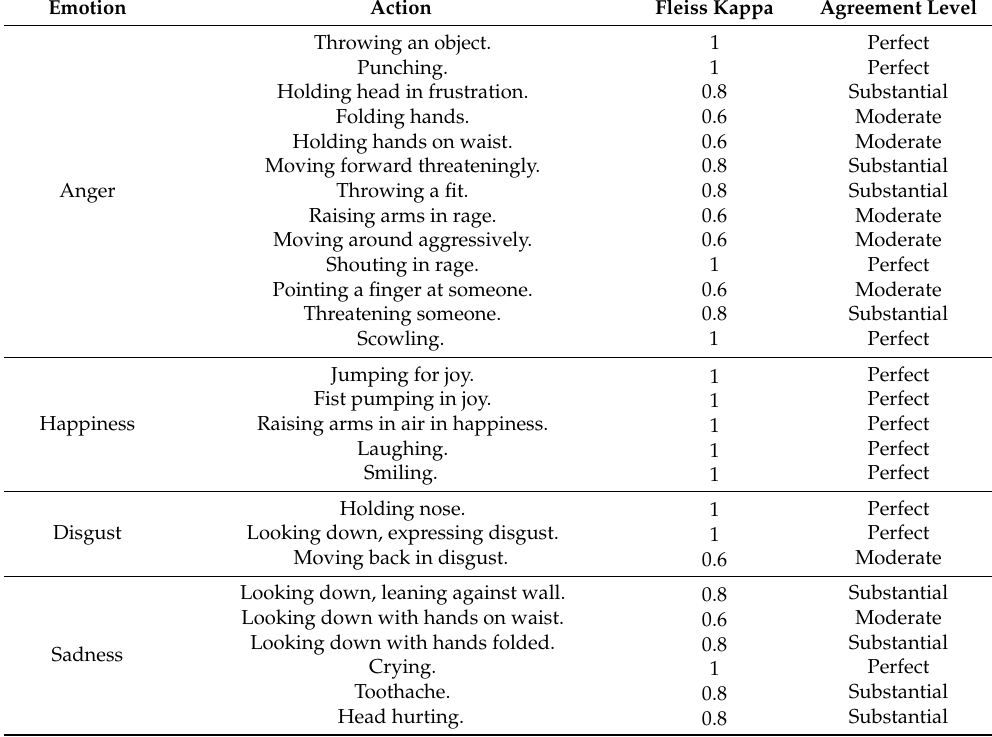
Distance between nose tip and forehead Distance between upper lip and forehead Distance between right wrist and head top Distance between left and right eyebrow Table 2. High-level poses and actions associated with spontaneous emotions. Emotion Action Agreement